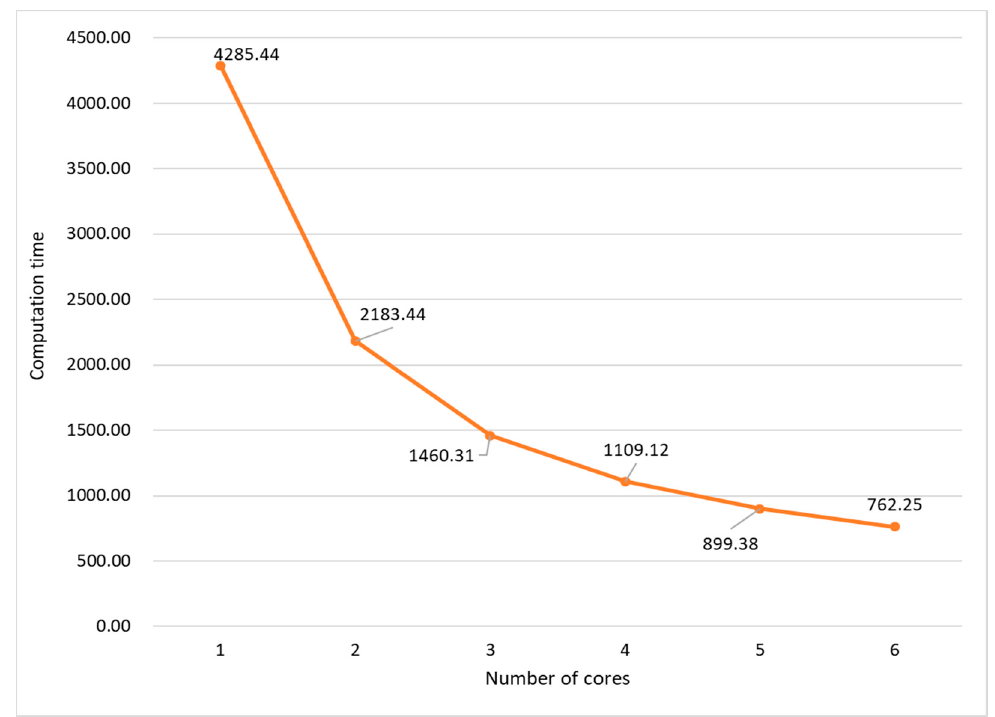
Figure 10. Computation time by using the OpenMP in software simulation.